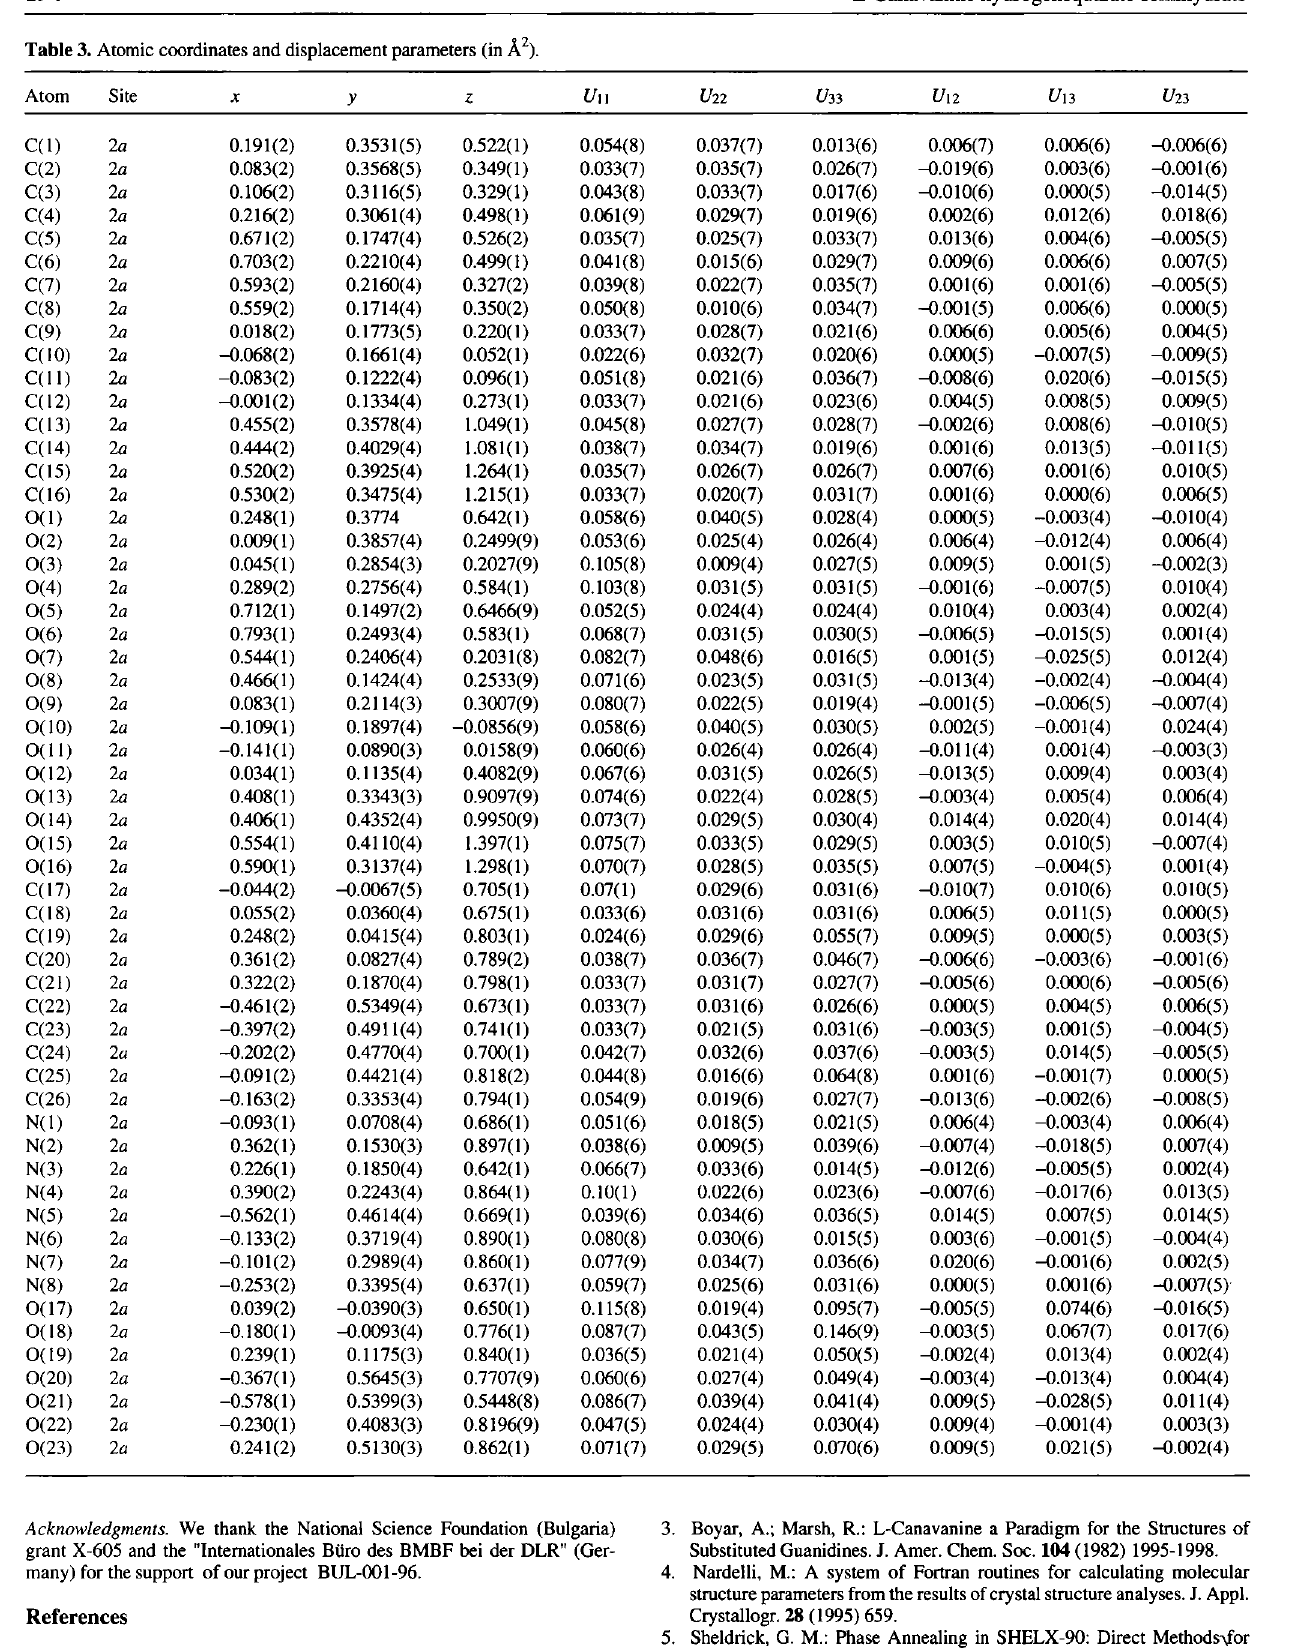
Table 3. Atomic coordinates and displacement parameters (in Ä 2